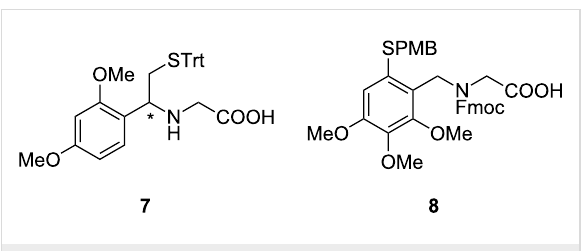
Figure 2: Structure of the glycine-linked auxiliary conjugates 7 and 8 .